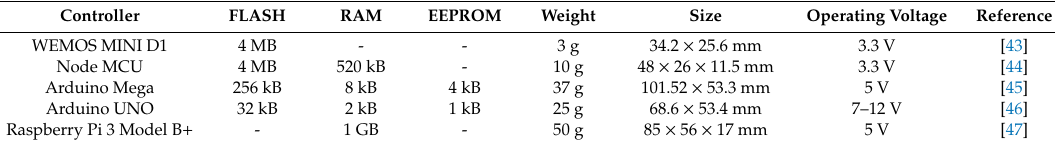
Table 2. Characteristics of popular nodes for Precision Agriculture (PA)